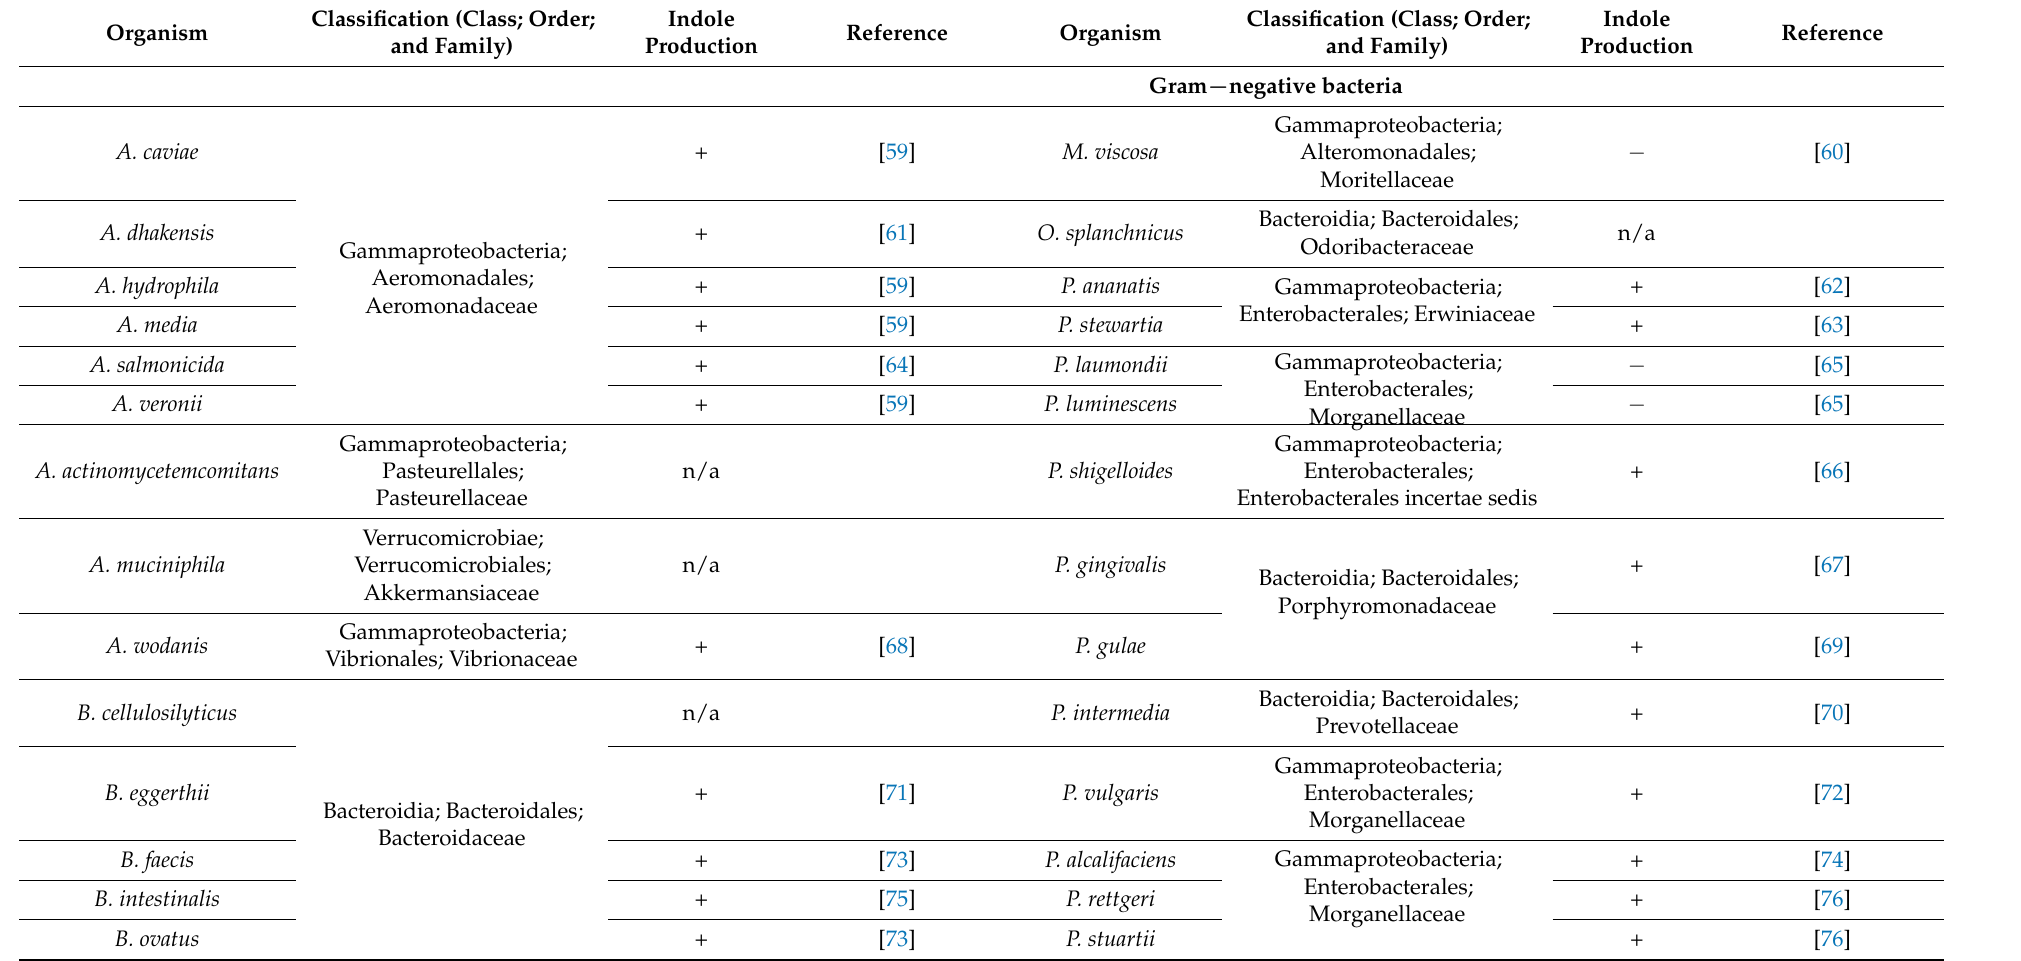
Table 1. Organisms used in the study and their classification and indole production + positive; − negative; n/a—not available; v—varying. Classification (Class; Order; Indole Organism Reference Organism and Family) Production